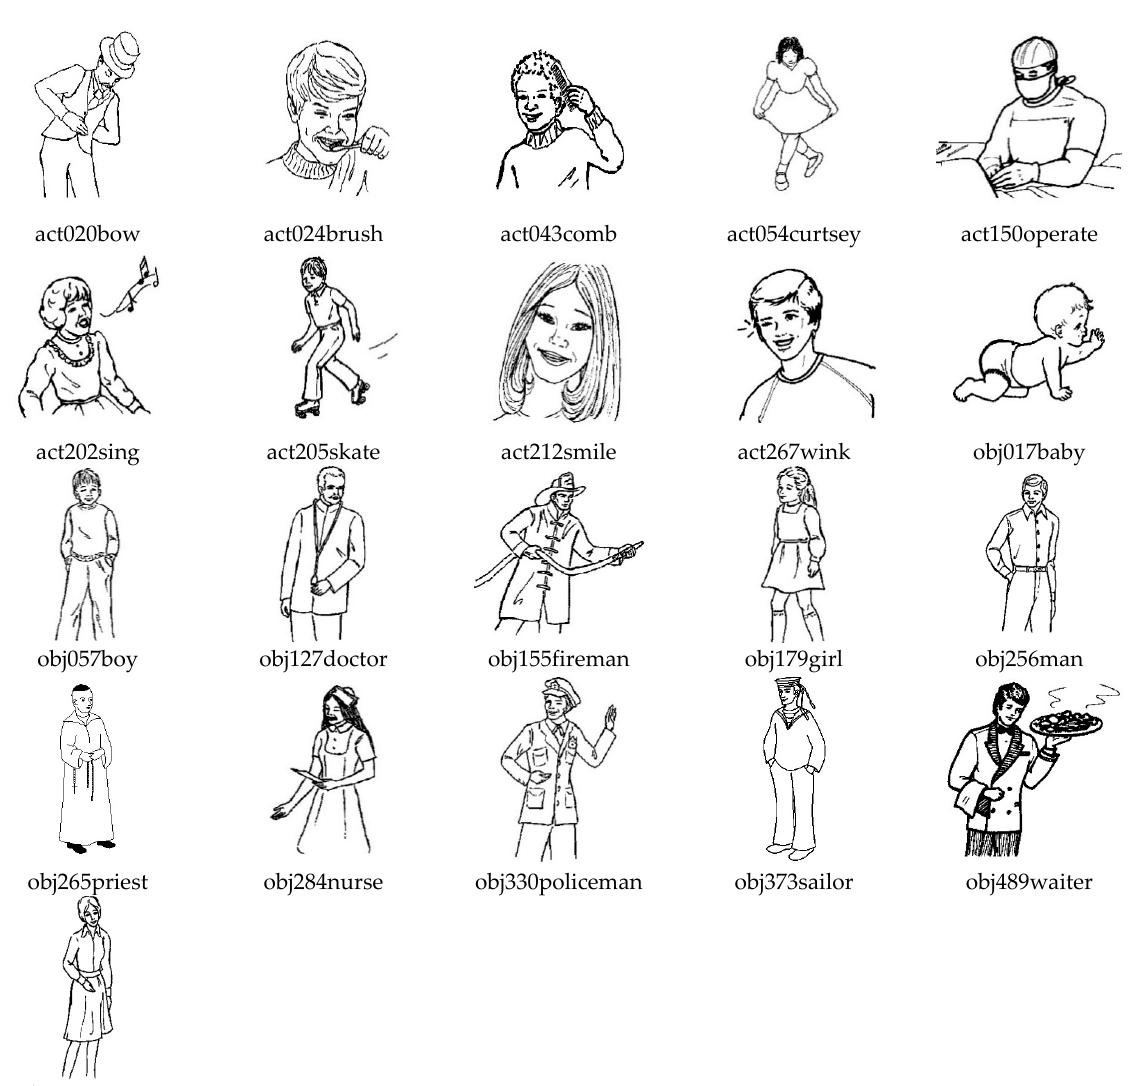
Figure A3. Animal pictures.